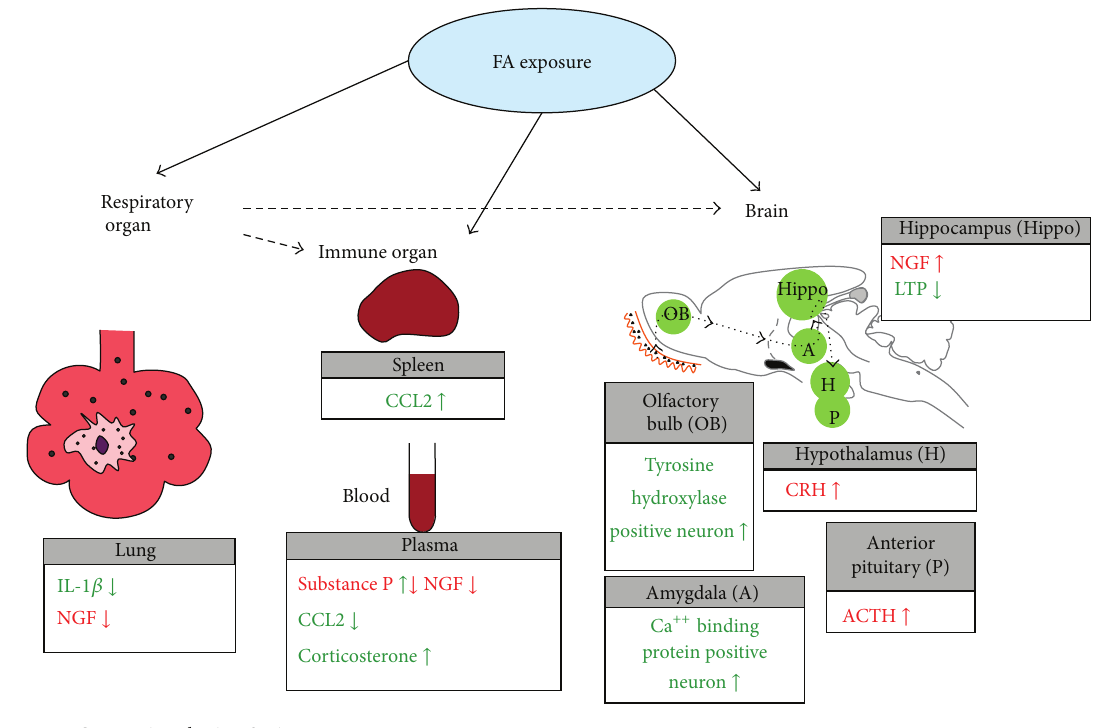
Figure 1: Possible target organs and biomarkers affected by formaldehyde exposure. FA exposure with or without OVA affects respiratory, immune, and central nervous systems by modulating the cytokines (IL-1 𝛽 , CCL2), neuropeptides (NGF, substance P), hormones (CRH, ACTH, and corticosterone), and enzymes (TH) and intracellular calcium-binding protein in the mouse model (green: FA, red: FA +